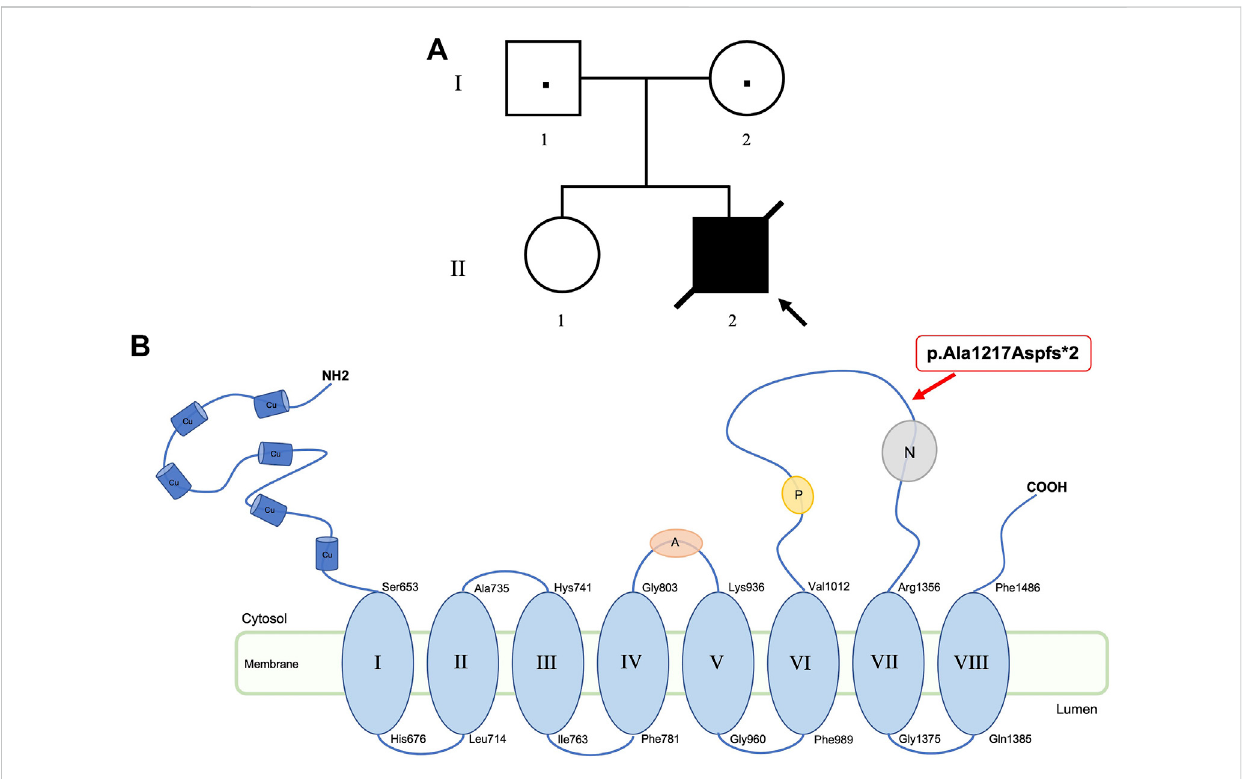
FIGURE 1 Pedigree of the family (A) . Location of ATP7A variant (p.Ala1217Aspfs*2) at protein level. ATP7A has six copper binding sites (Cu), eight transmembrane domains, an activation domain (A), a phosphorylation domain (P), and a nucleotide domain (N) (B)